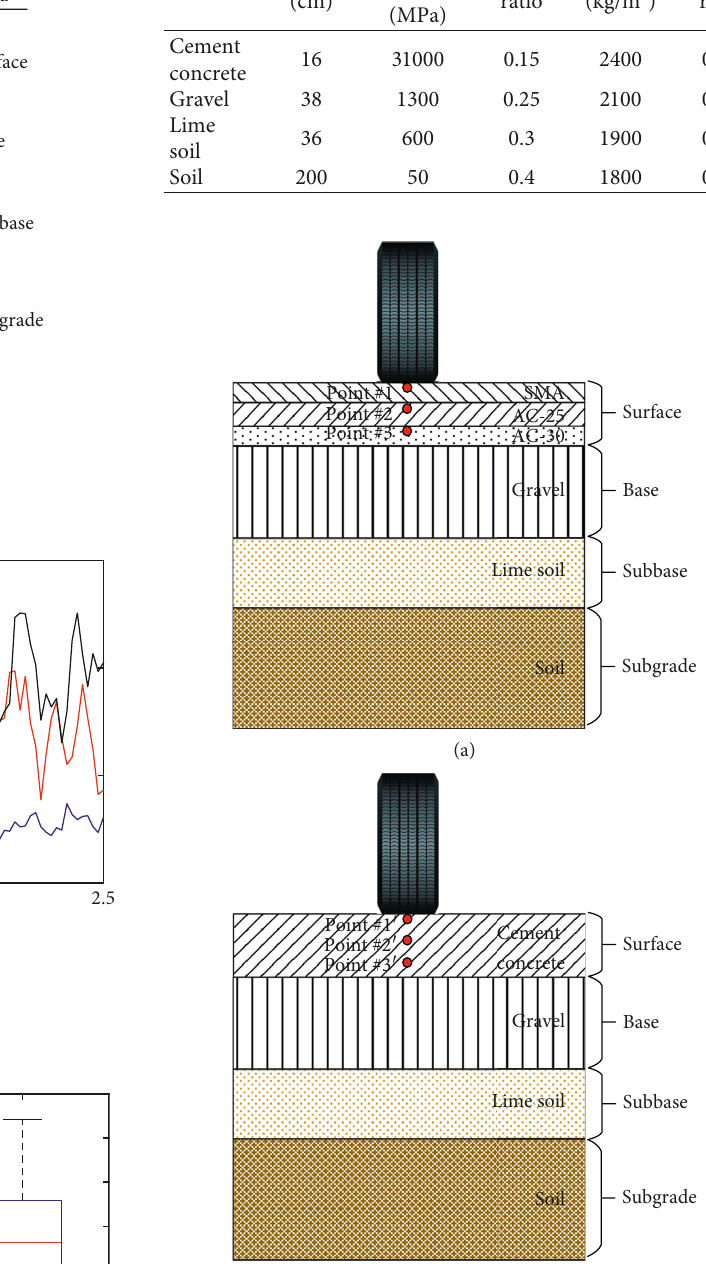
Figure 12: The monitoring points on the transverse section of the model center between asphalt and cement concrete pavements. (a) Asphalt concrete pavement. (b) Cement concrete